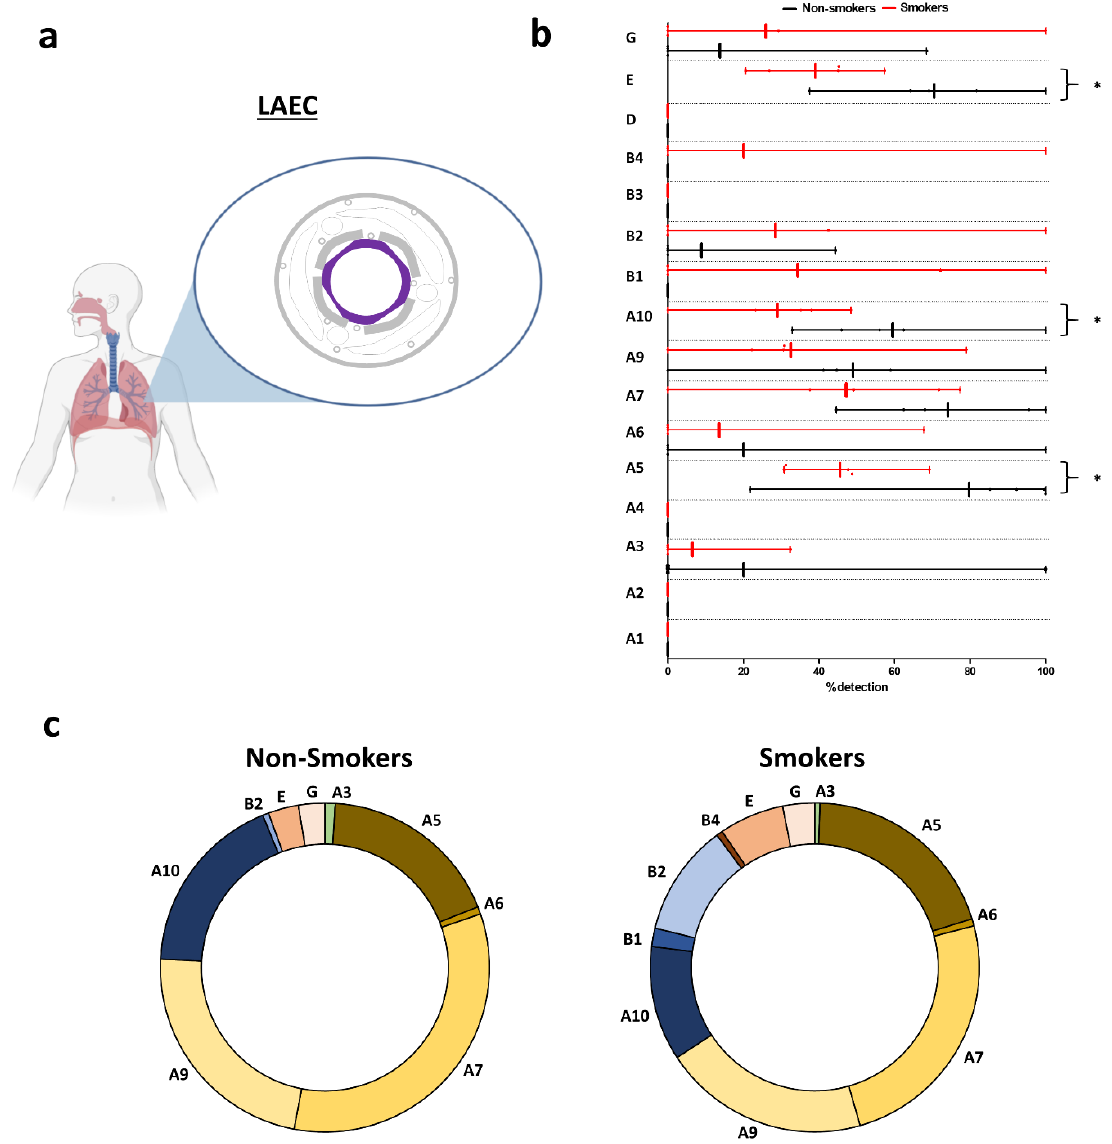
Figure 2. Evaluation of nAChR transcript levels in human large airway epithelial cells (LAECs). ( a ) Illustration depicting the origin of the samples. Isolated AECs were collected from bronchi. Large airway epithelial cells (LAECs) are depicted in purple. ( b ) Histogram showing the detection of nAChRs in non-smokers (black) and smokers (red). * p < 0.05 non-smokers ( n = 5) vs. smokers ( n = 5). ( c ) Pie charts showing the repartition of nAChRs in non-smokers (left) and smokers (right).